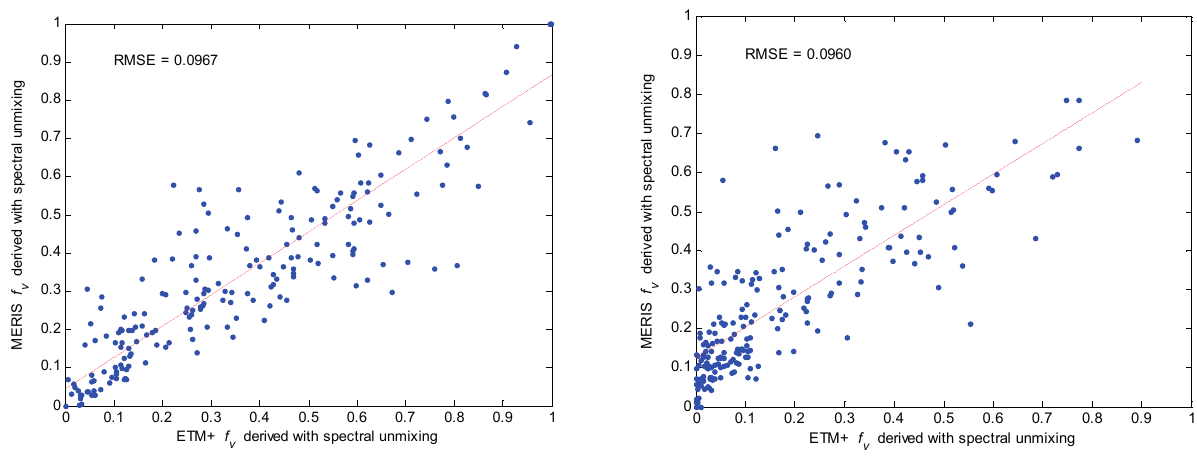
Figure 11. A scatter plot showing a correlation between f pixels and the corresponding mean f and image pair 2 ( right